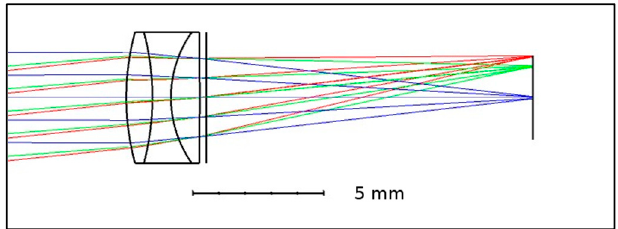
Figure 1. Ray trace diagram of the custom designed triplet lens from our thermal imaging camera design. The lens was designed using the commercially available ray tracing software, Optic Studio. All the optical elements were stock items.